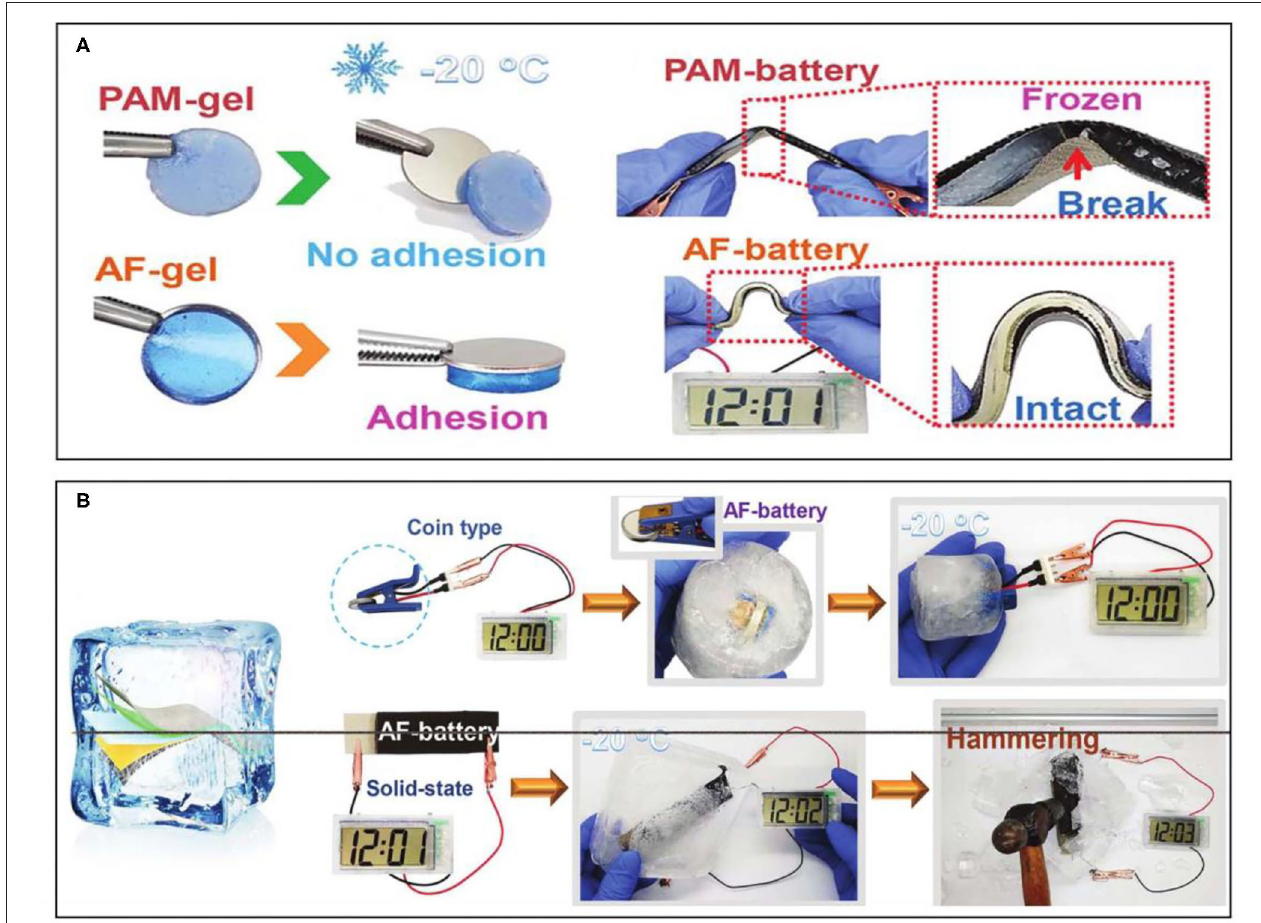
FIGURE 3 | (A) Comparisons of the adhesion force and bending demonstration of PAM-battery and AF-battery at − 20 ◦ C. (B) Application demonstration of the AF-battery at subzero temperatures. Reprinted with permission from Mo et al. (2019). Copyright (2019) Royal Society of Chemistry.